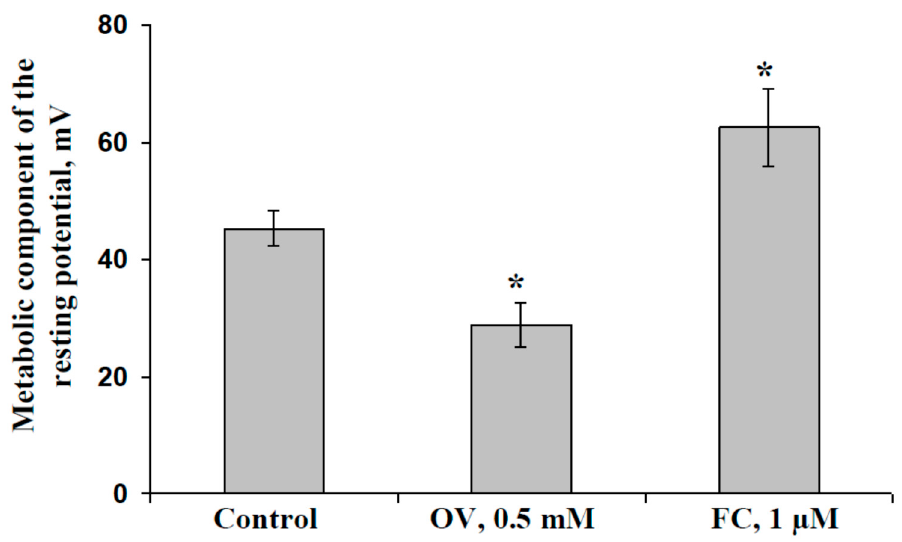
Figure 1. Average magnitudes of the metabolic component of the resting potential of cells of leaves in pea seedlings under control conditions and after preliminary treatment with fusicoccin (FC) and sodium orthovanadate (OV) ( n = 6–10). The magnitude of the metabolic component, which showed H + -ATPase activity in the plasma membrane, was estimated on the basis of short-term changes in membrane potential after the action of the high OV concentration (see Section 4.2 and Figure S4 for details). The second mature leaves in seedlings were preliminarily treated with OV (0.5 mM) and FC (1 µ M) treatments by incubation of the leaf (2 h) in solutions of these chemical agents; after that, these leaves were dried by filter paper and used for intracellular measurement of electrical activity. OV and FC were dissolved in standard solution (1 mM KCl, 0.5 mM CaCl 2 , and 0.1 mM NaCl). Similar incubation in the standard solution was used as the control. *, di ff erence between experiment and control plants was significant ( p < 0.05).